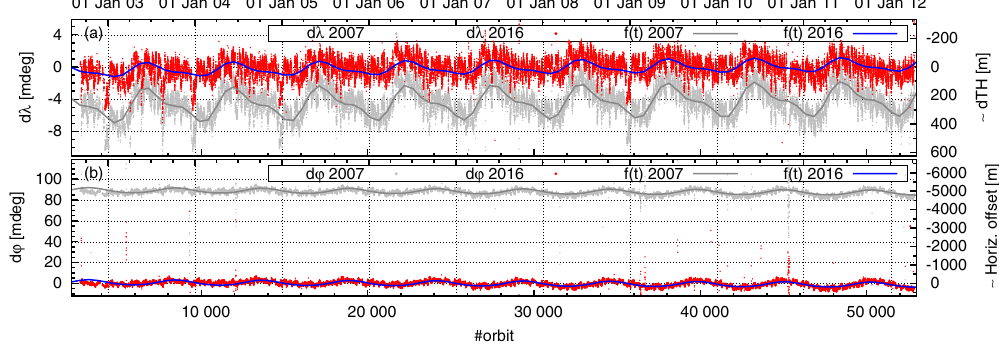
Figure 10. Solar occultation mispointing with mispointing parameters as defined in 2007 (grey) and with the newly fitted mispointing parameters (labelled 2016). (a) Elevation angle offset dλ . (b) Azimuth angle offset dϕ . The lines are a function with a constant, a linear and an annual and semiannual sinusoidal term, fitted to the datasets (for details see Bramstedt et al., 2012). With the newly fitted parameters, offsets for both angles are close to zero. Table 3. Envisat and SCIAMACHY mispointing parameters. “AOCS”: these mispointing parameters are part of Attitude and Orbit Control System (AOCS) of Envisat and describe the initial platform mispointing, here only shown for comparison. “Scanner control”: SCIAMACHY mispointing as determined before launch. These mispointing angles are also used in the scanner control of SCIAMACHY. “Extra mispoint- ing”: in the analysis Gottwald et al. (2007), the mispointing was derived relative to the mispointing already implemented in the scanner control. “SCIAMACHY mispointing”: these four columns describe the mispointing parameters as used in the L0-1 processing. “Launch”: for the first processor versions since launch, no mispointing was assumed. “First 2007”: first attempt to recognise the 2007 analysis. “Final 2007”: final settings from the 2007 analysis, which should be the sum of scanner control and extra mispointing. “New fit”: mispointing parameters as determined by this work. Beyond mispointing angles in pitch, roll and yaw, also offsets to the scanner positions (dpos ESM , dpos ASM ) are determined. Version 9 is the proposed processor version to implement the new mispointing